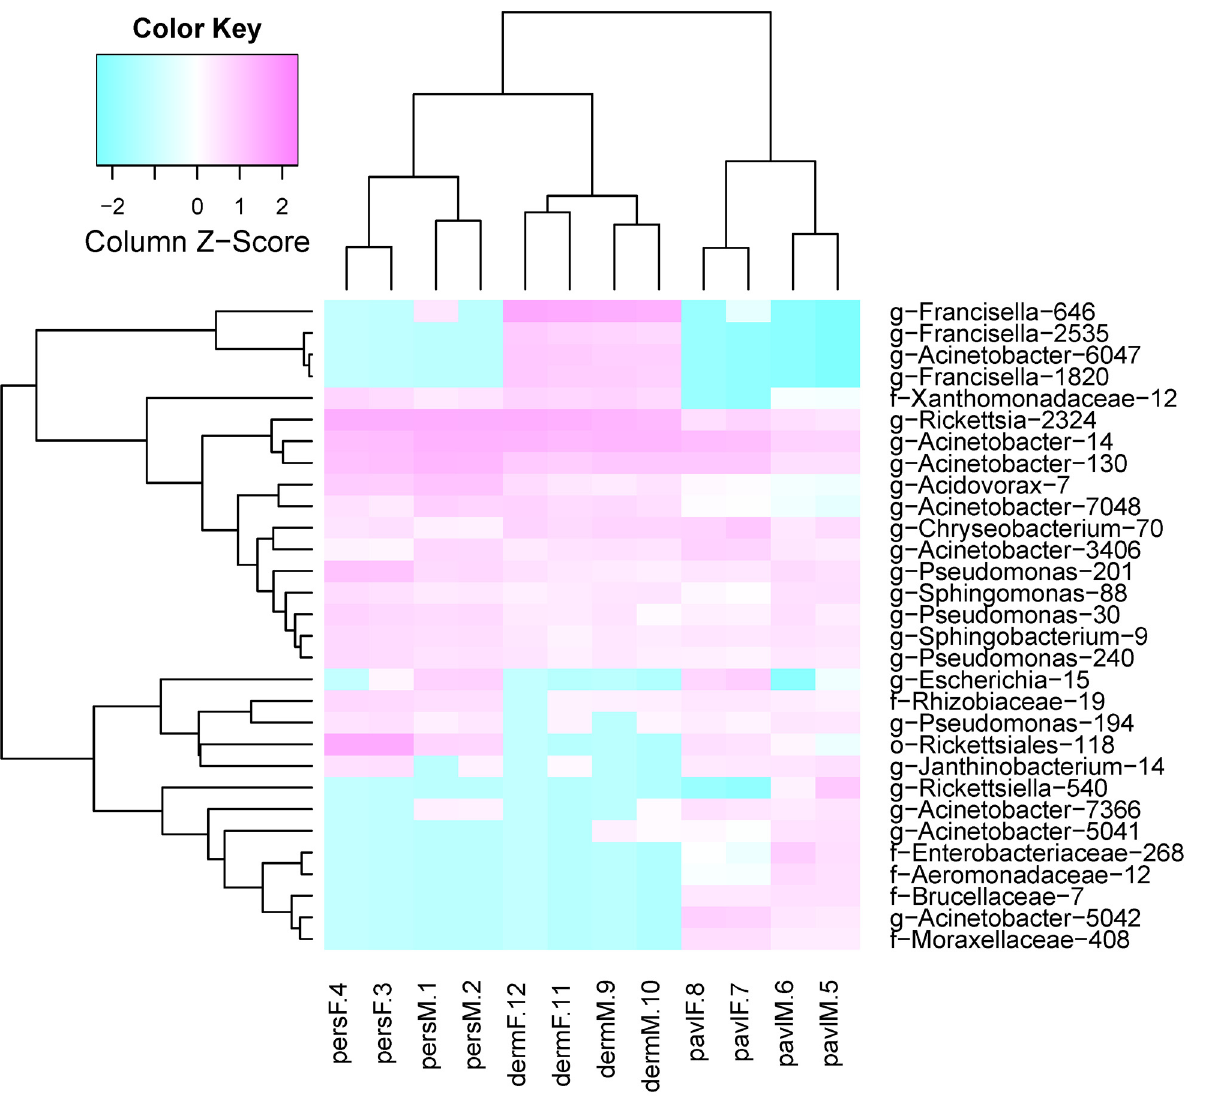
Fig 1. Heatmap based on 30 mostly reprepreted OTUs. Heatmap was constructed using euclidean distance method for log-scaled in-sample taxon share values. Sample names on the X axis consist of tick species, sex and library number. OTU names on the Y axis contain OTU's lowest common ancestor name and unique integer OTU